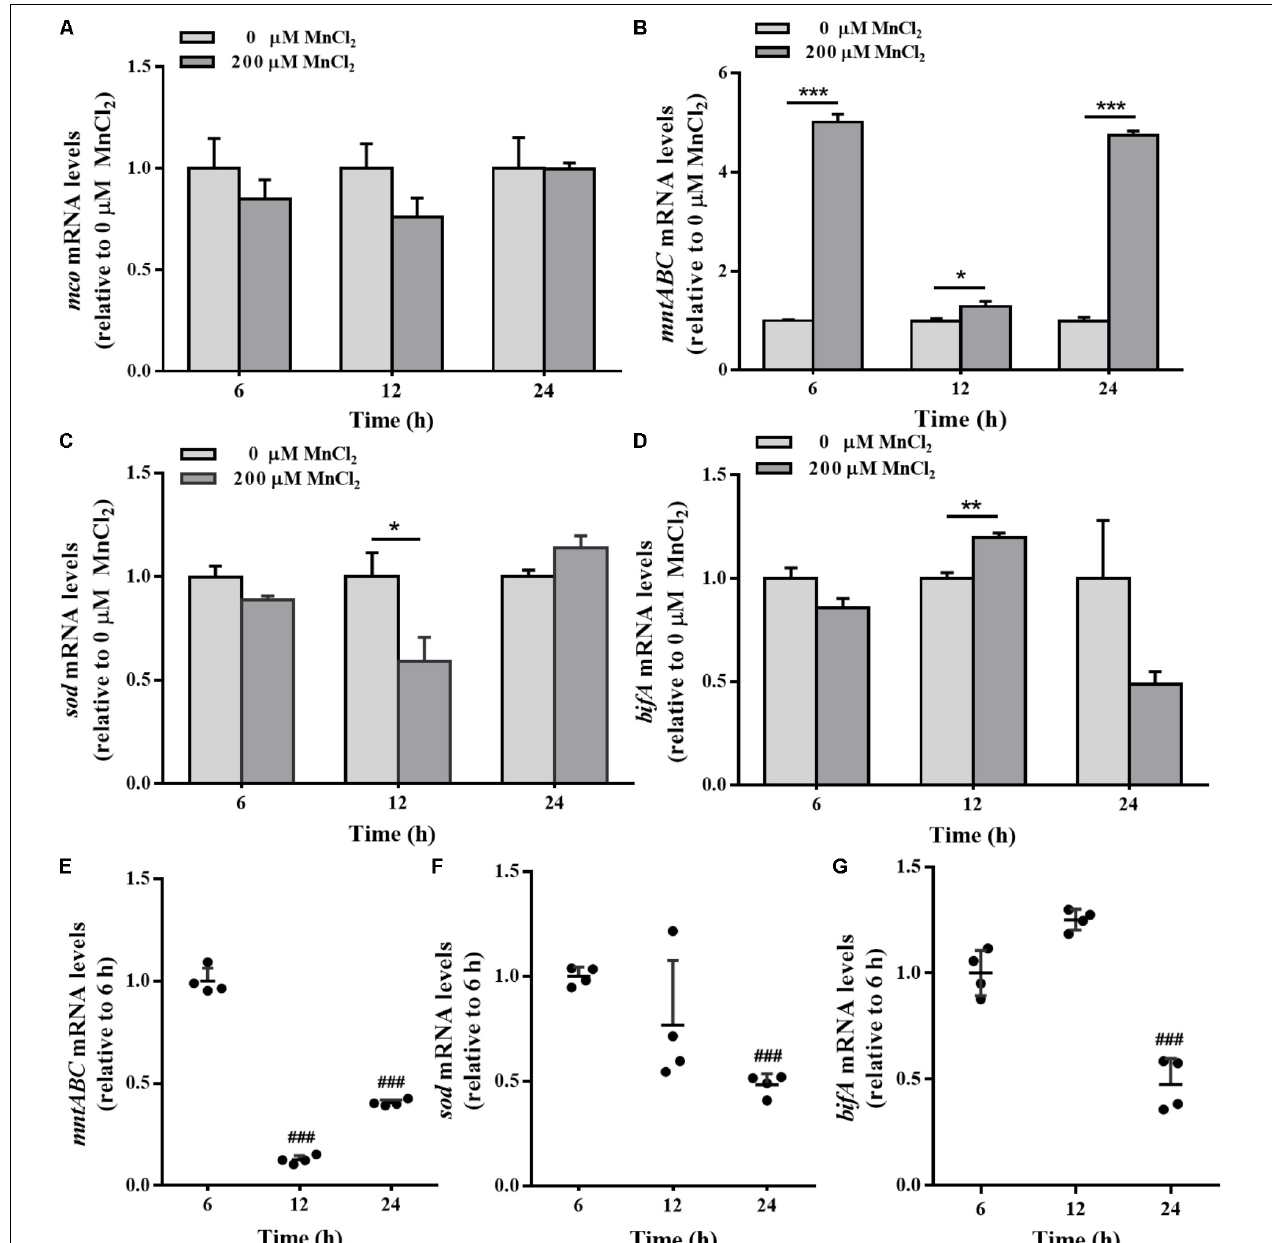
FIGURE 8 | The mco, mntABC , sod, and bifA mRNA levels in biofilm cells as well as during biofilm development with exogenous Mn 2 + . mco (A) , mntABC (B) , sod (C) , and bifA (D) mRNA levels in colonized cells incubated with 200 µ M Mn 2 + for 2 h after 6, 12, and 24 h cultivation for adhesion, were detected by qRT-PCR, respectively. The cellular mRNA levels of mntABC (E) , sod (F) , and bifA (G) at different stages of biofilm formation were detected by qRT-PCR, respectively. Relative gene expression levels of mco, mntABC , sod and bifA were normalized to 16s rRNA ( n = 4), respectively. Data were expressed as mean ± SEM. Significance, ∗ P < 0.05, ∗∗ P < 0.01, and ∗∗∗ P < 0.001 vs. control group (0 µ M MnCl 2 ). ### P < 0.001 vs. 3 h-biofilm formation